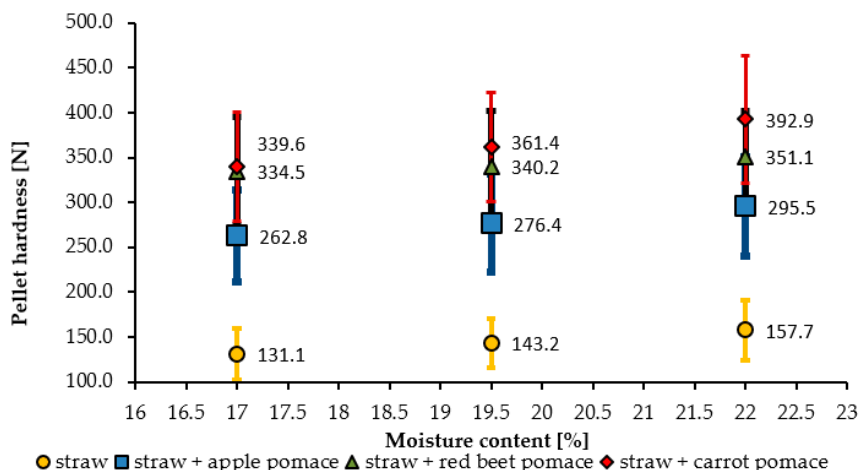
Figure 6. Effect of the additive contribution in the mix with barley straw on the hardness of pro- duced pellet.